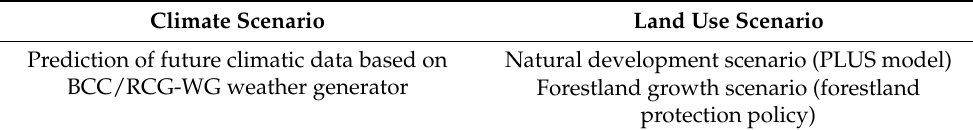
Table 1. Scenario analysis settings.